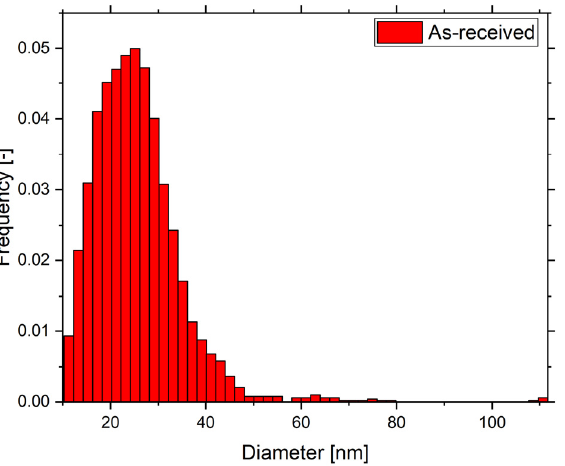
Figure 3. The normalized distribution of particle size described by diameter recalculated from area in as-received state.